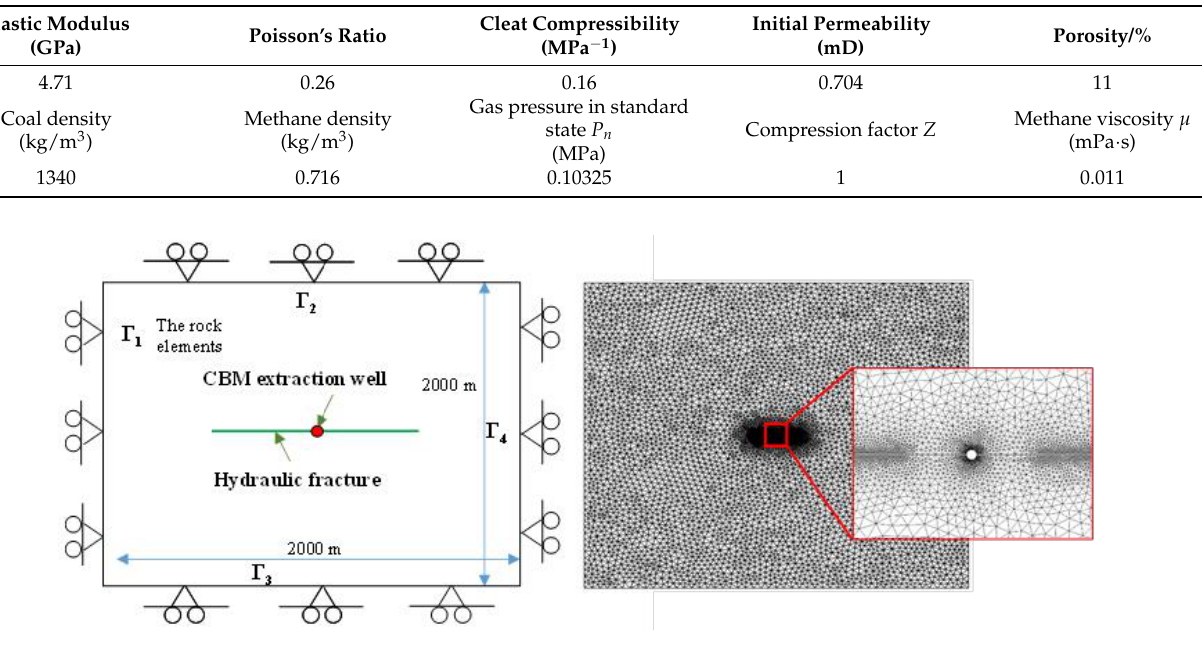
Figure 5. The calculation model of CBM reservoir.